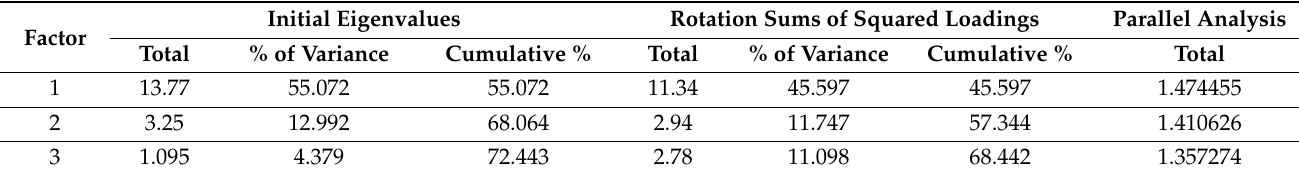
Table 11. Calculated eigenvalues